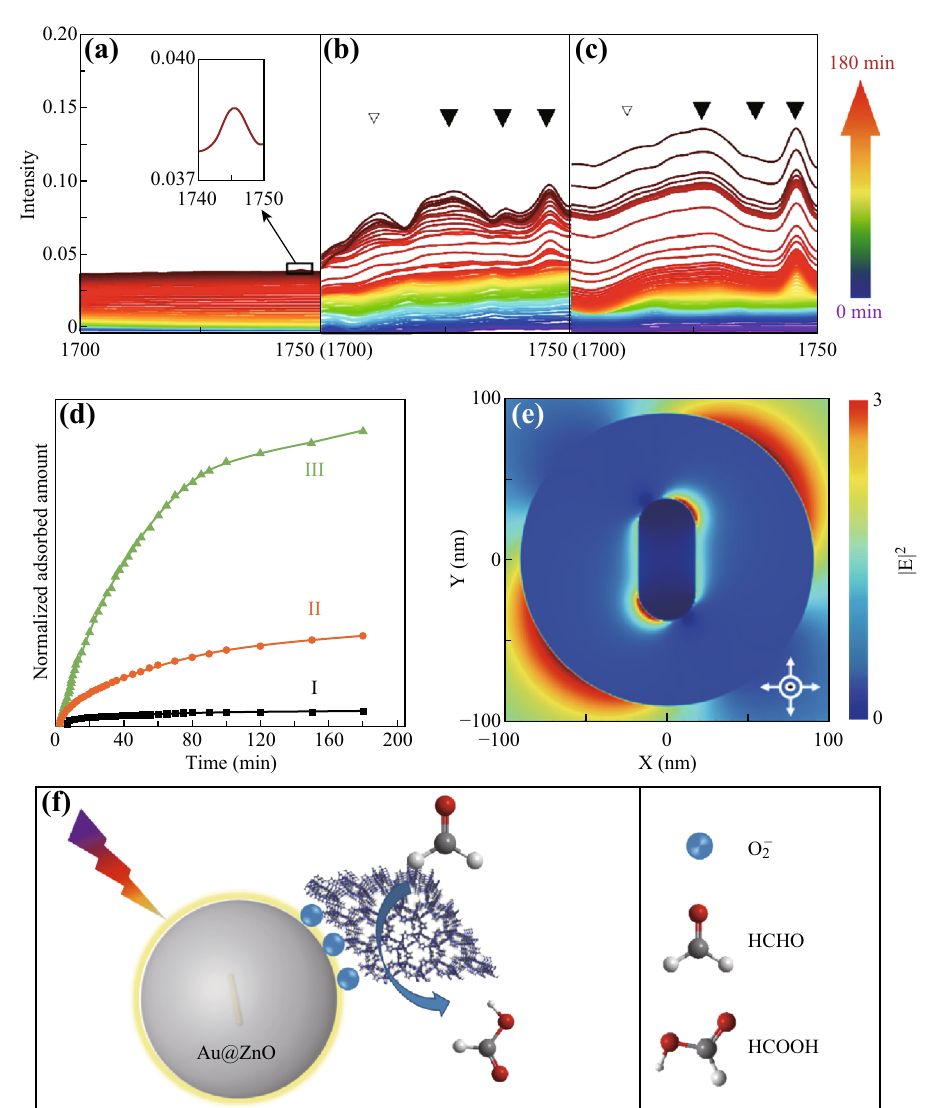
Fig. 6 Time-resolved DRIFTS spectra on a Sample I, b Sample II, and c Sample III. d Their corresponding kinetics of HCHO adsorption (solid symbols), the blue curve represents the production kinetic of formic acid for sample II. e Enhancement of local electromagnetic field of Au@ZnO NPs. f Proposed mechanism of oxidation of HCHO into